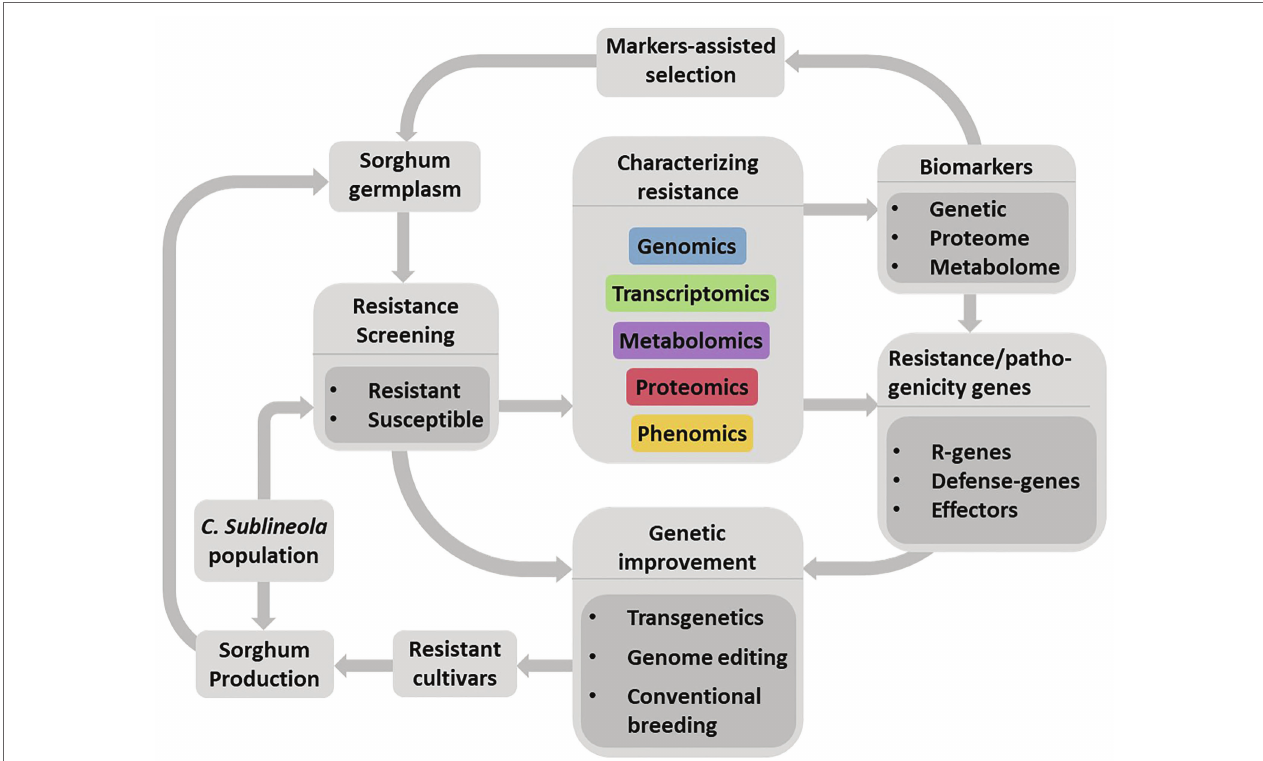
FIGURE 3 | Schematic flow representing a strategy for the development of anthracnose resistant sorghum cultivars through the identification of resistance sources, development and application of biomarkers as well as understanding the pathosystems. Large-scale resistance screening using diverse C. sublineola strains would lead to the identification of resistant and susceptible genotypes. Integrated omics is an efficient approach to identify and characterize compatible (susceptibility) and incompatible (resistance) reaction of sorghum genotypes as well as to identify markers related to plant defense and pathogenicity factors. Availability of genomic information on sorghum and C. sublineola would enable efficient application of integrated omics approach to unravel their interactions. Validated markers for their association with the target trait can facilitate the identification of resistant genotypes in a diverse sorghum germplasm while defense related genes, particularly major R -genes are useful for genetic improvement of sorghum cultivars. However, the ever-evolving pathogen populations continue to pose a challenge to resistant cultivars deployed for production. Hence, it is important to add newly identified resistant cultivars to existing resistance gene pool and frequently re-evaluate their resistance against new C. sublineola strains to ensure durability of the